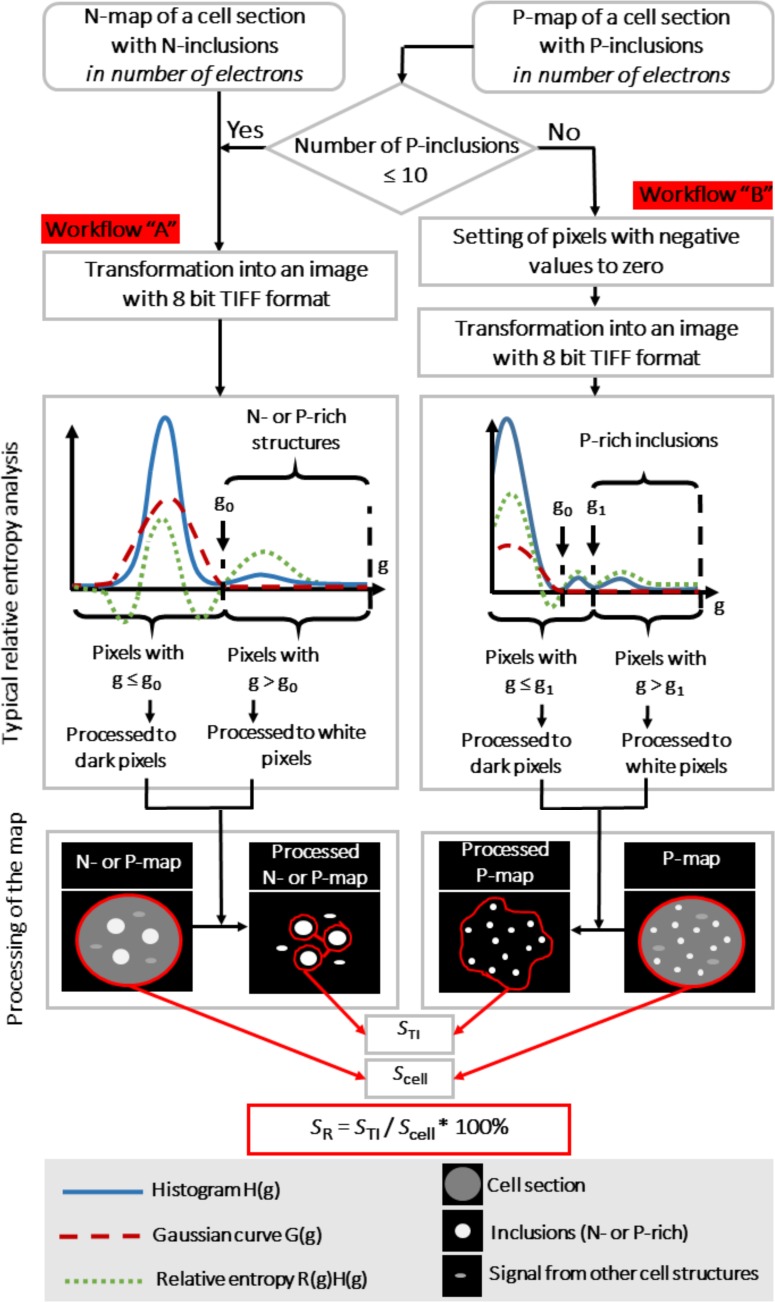
Scheme of the processing of EFTEM N- and P-maps.The method of EFTEM maps processing may be implemented via two alternative workflows. The workflow “A” (left column) is used for processing N-maps and low-phosphorus maps (less than 10 PRIs per cell section), the workflow “B” (right column) is used for processing P-maps with more than 10 PRIs per cell section. The workflows are based on comparison of the a posteriori probability that a map pixel contains payload information and the Gaussian a priori probability of that the pixel belongs to noise. The difference is expressed as relative entropy value for each pixel so pixels with positive relative entropy values grouped in the right half of the histogram do not belong to the noise. After the relative entropy analysis of each pixel and subsequent binary thresholding of the map, a simple assessment of the relative area and localization of the inclusions on the cell section is carried out. STI−total pixel area of the cell inclusions, Scell−total pixel cell area, SR−relative area of P or N reserves. See text and S1 and S2 Appendices for details.